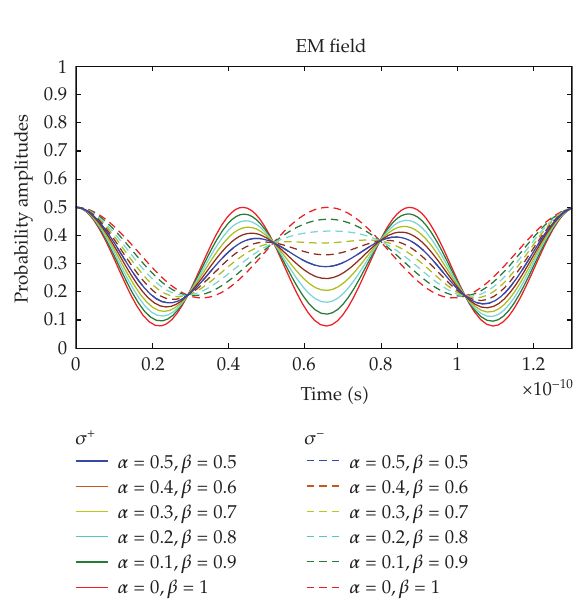
Figure 8: Right and left circular polarization prob. amplitudes for small Δ